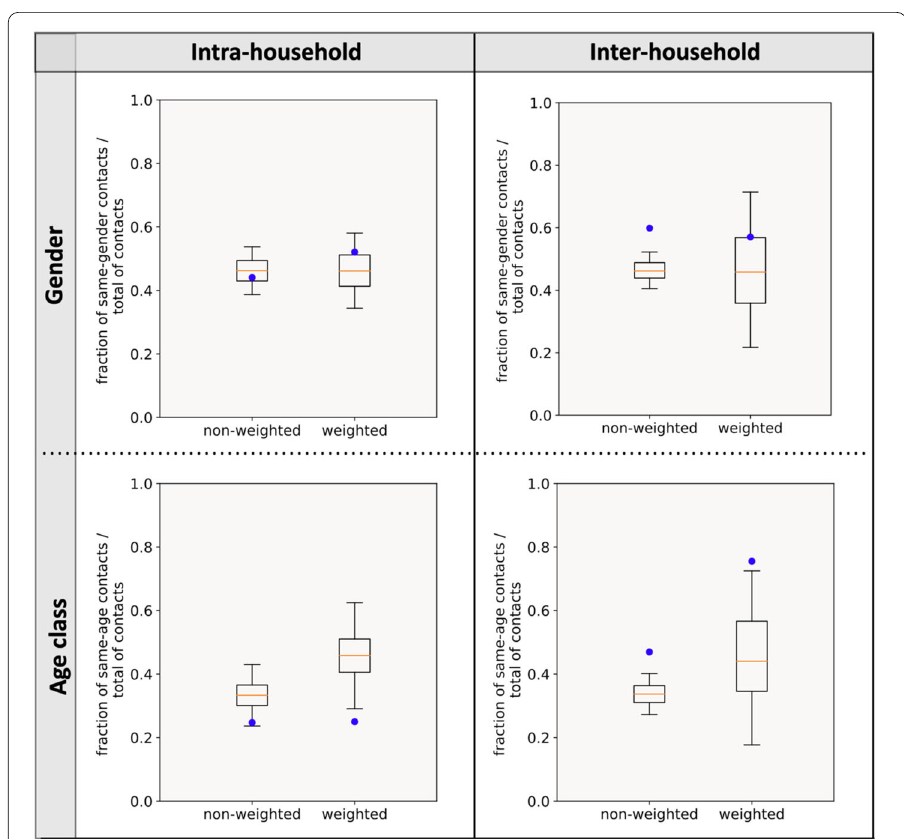
Figure 4 Statistical test of gender and age assortativity for inter and intra household contacts (non-weighted = fraction of contact events; weighted = fraction of total time in contact). Blue dots indicate the empirical values involving individuals of the same gender and age. Box plots show the distribution of the fraction of contact events (non-weighted) and fraction of total time in contact (weighted) resulting from the null model. In each box, the orange line marks the median and the extremities of the box correspond to the 25 and 75 percentiles: the whiskers give the 5 and 95 percentiles of each